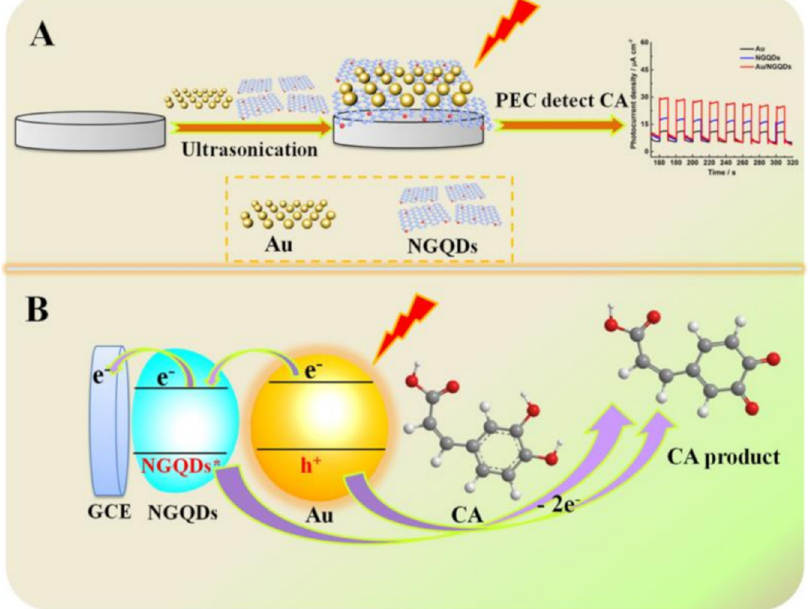
Figure 8. ( A ) Assembly of Au/NGQDs sensing platform for the photo-electrochemical (PEC) detec- tion of caffeic acid (CA). ( B ) Schematic illustration of the sensing mechanism. Reprinted from [98].